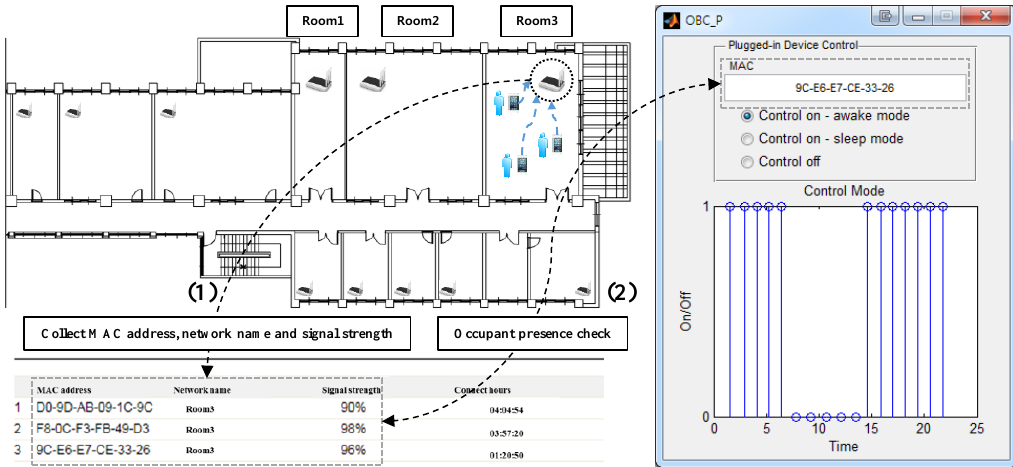
Figure 5. Occupant presence check method.